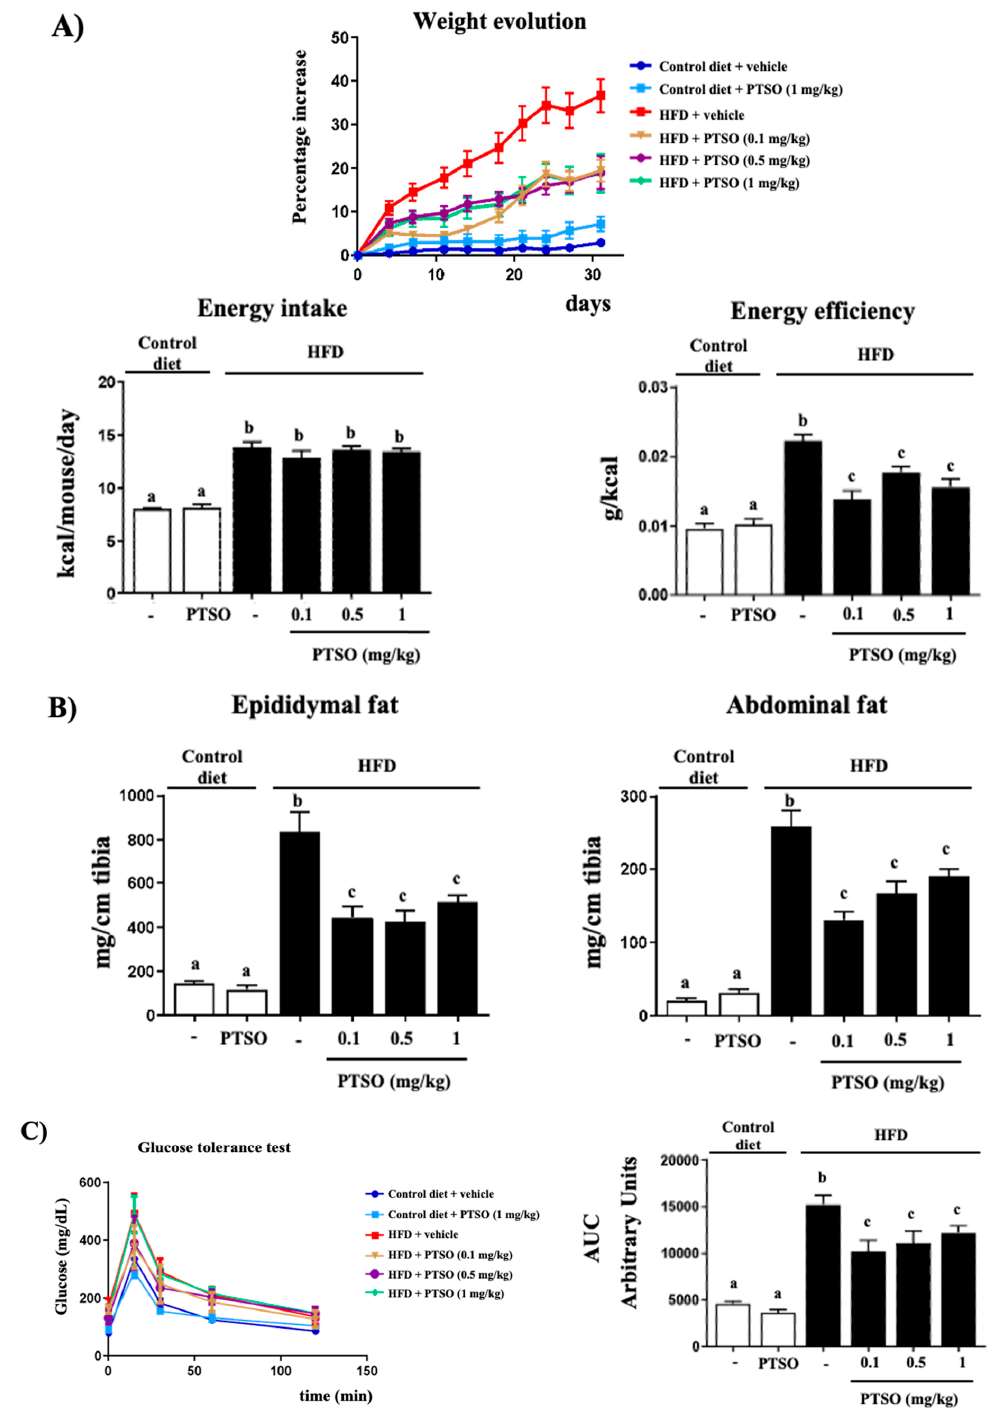
Figure 1. Effects of propyl propane thiosulfonate (PTSO) administration on ( A ) morphological changes (body weight evolution, energy efficiency and energy intake); ( B ) epididymal and abdominal fat; ( C ) glucose tolerance test and area under the curve (AUC) in the control and high-fat diet (HFD)-fed mice. Groups with different letters statistically differed ( p <